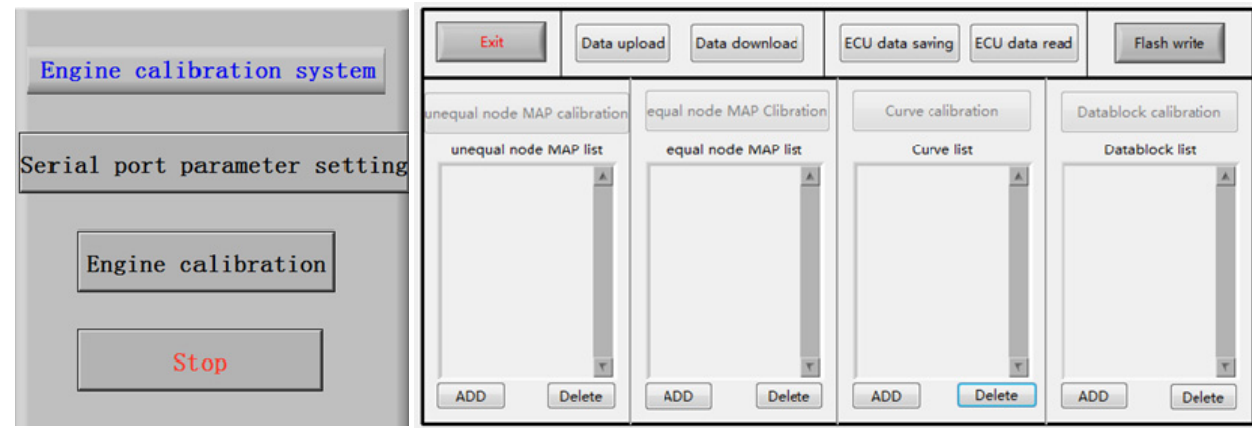
Figure 2. The calibration interface based on